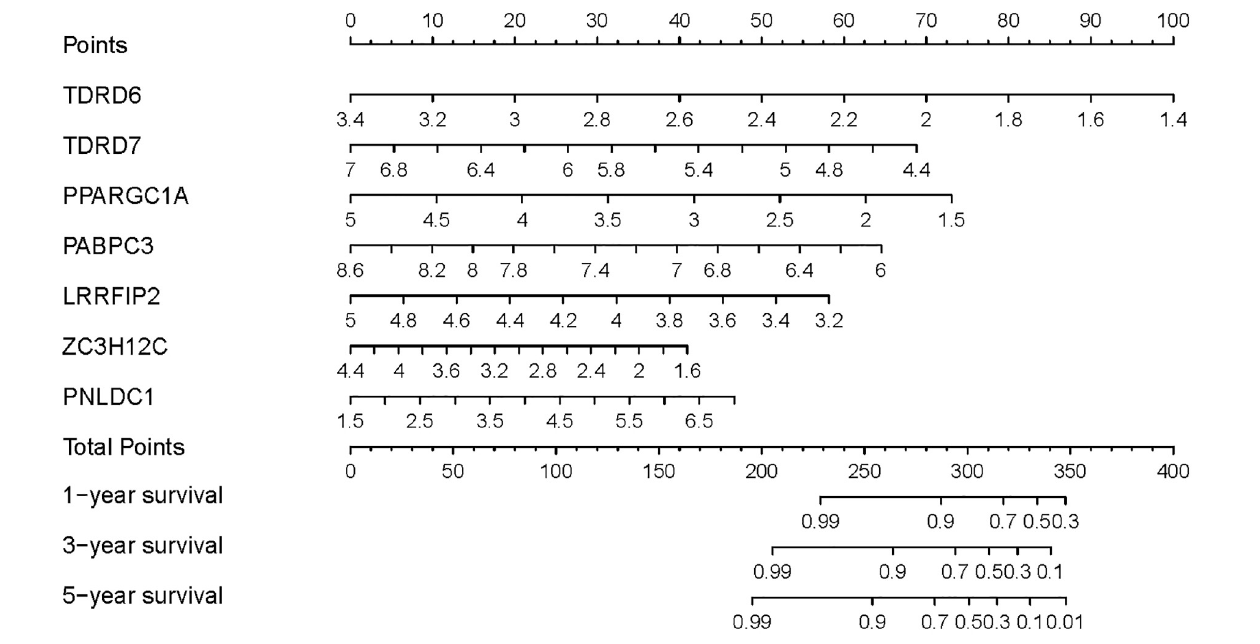
Frontiers in Cell and Developmental Biology |